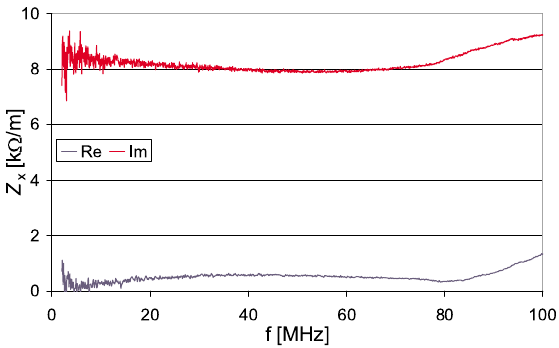
FIG. 25. (Color) Horizontal impedance of K1 kicker magnet.